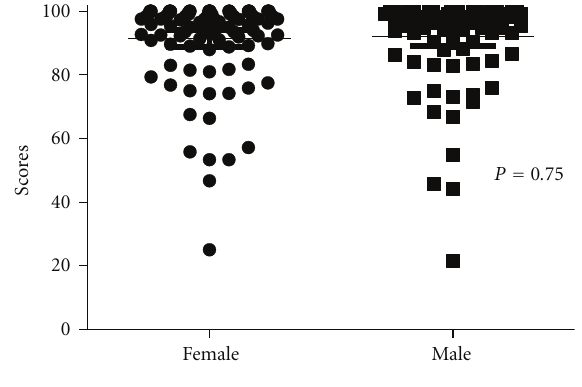
Figure 1: The TESS by gender (all patients).